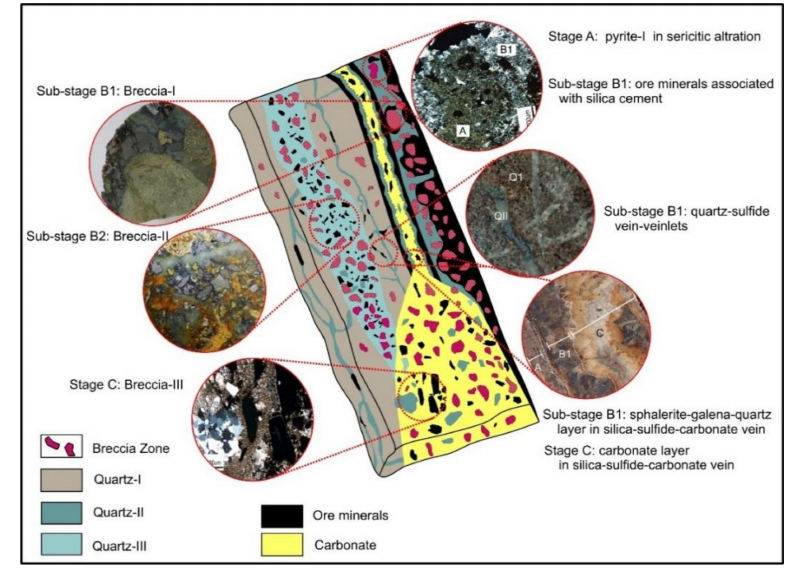
Figure 25. Schematic presentation of Shah-Ali-Beiglou vein-type deposit, illustrating multiple phases of ore mineral deposition and fracturing events. Stage A: The pre-ore stage in which pyrite-I was deposited as isolated grains. Stage B1: The earliest stage of ore mineralization (ore stage) was developed as hydrothermal breccias and vein-veinlets. Stage B2: The ore mineralization continued as breccia cement associated with pyrite. Stage C: The post-ore stage, which is marked by mostly carbonate as breccia cement and vein-veinlet that are associated with